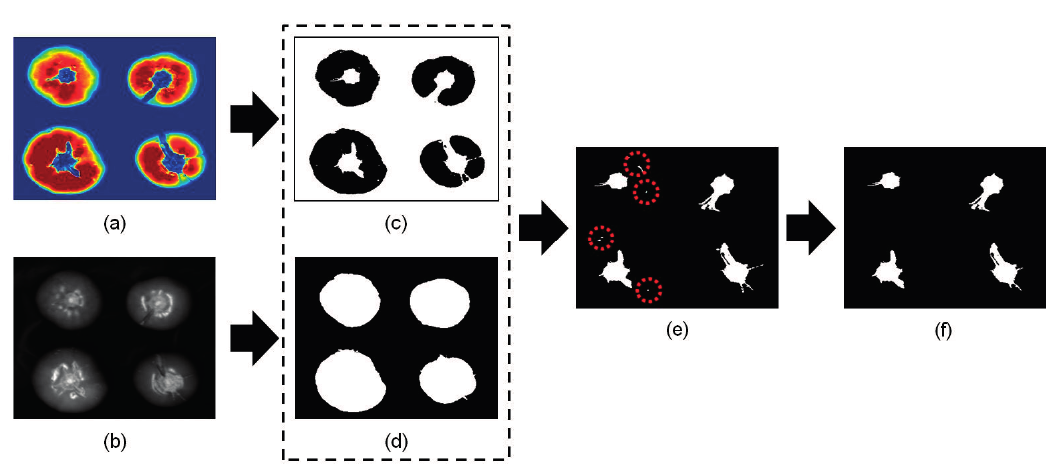
Figure 5. Image processing procedure to detect cracks on tomatoes. ( a ) PLS-DA image obtained from the re-developed model. ( b ) Single wavelength masking image obtained at 1098 nm. ( c ) PLS-DA binary image obtained using a threshold value of 0.5. ( d ) Masking image. ( e ) The image obtained by combining the PLS-DA binary image (c) with the masking image (d). ( f ) Final image after removal of the scattered pixels.